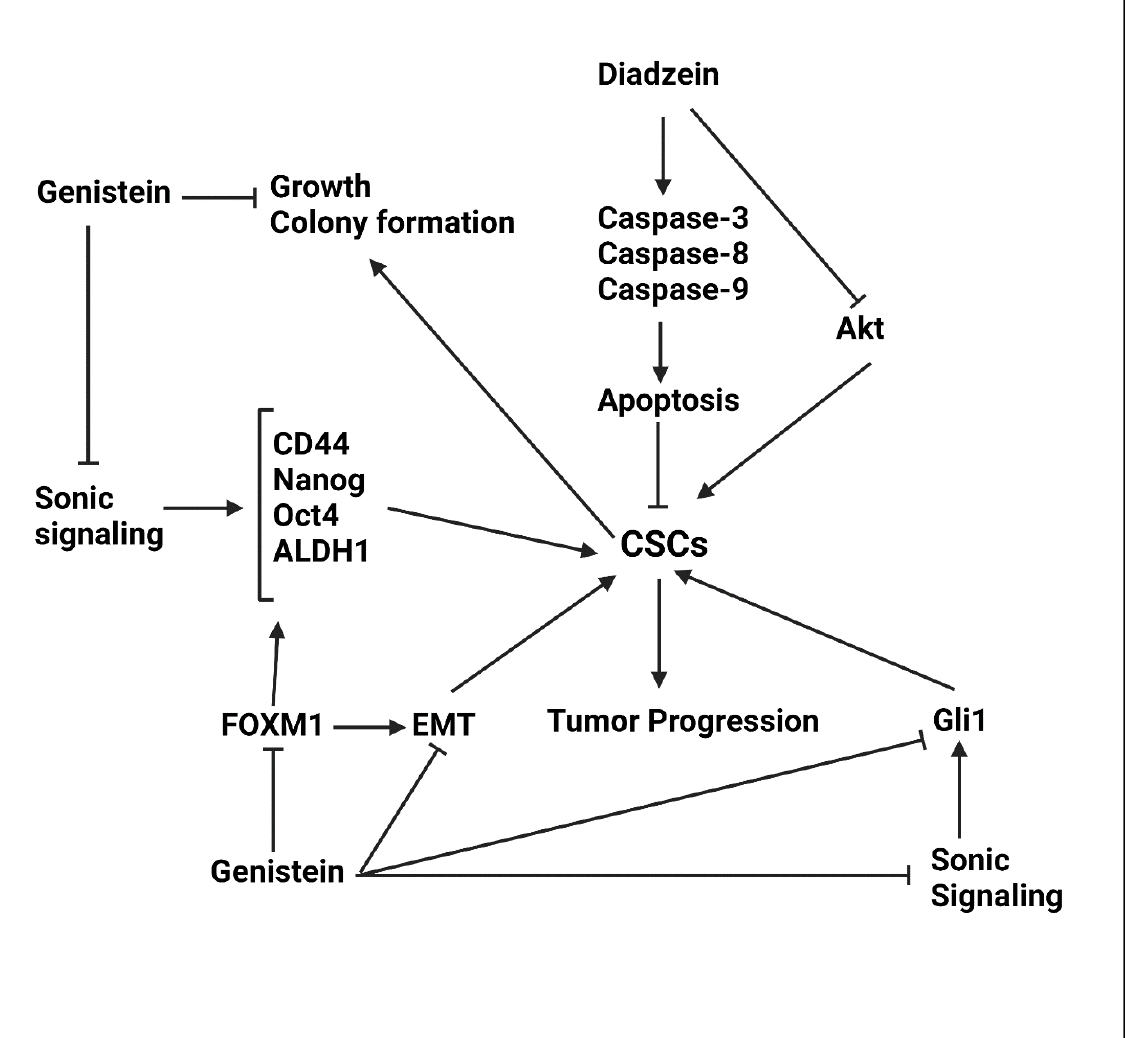
Figure 2. The potential of isoflavonoids in suppressing CSCs. Table 3. The potential of genistein in cancer suppression via targeting CSCs.